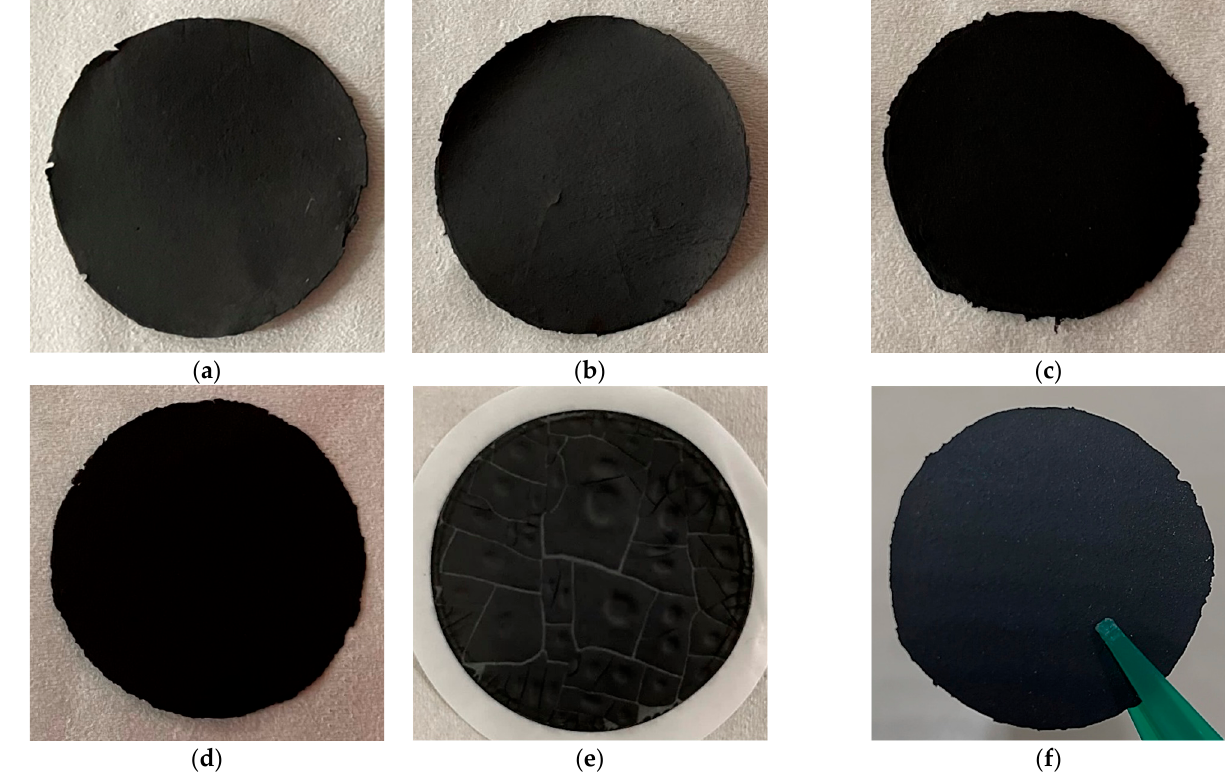
Figure 1. Pictures of ( a ) SWCNT BP, ( b ) 25% GO-SWCNT BP, ( c ) 50% GO-SWCNT BP, ( d ) 75% GO-SWCNT BP, and ( e ) 85% GO-SWCNT BP. All samples, except for 85% GO-SWCNT BP (which showed evident macroscopic cracks), were easy detachable from the porous PTFE filter and resulted in ( f ) self-sustainable and flexible disks.